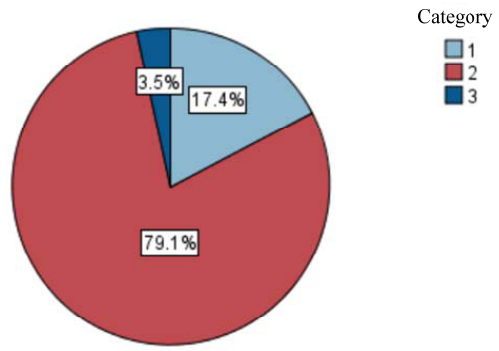
Table 3. Clustering distribution of pupil diameter change rate.